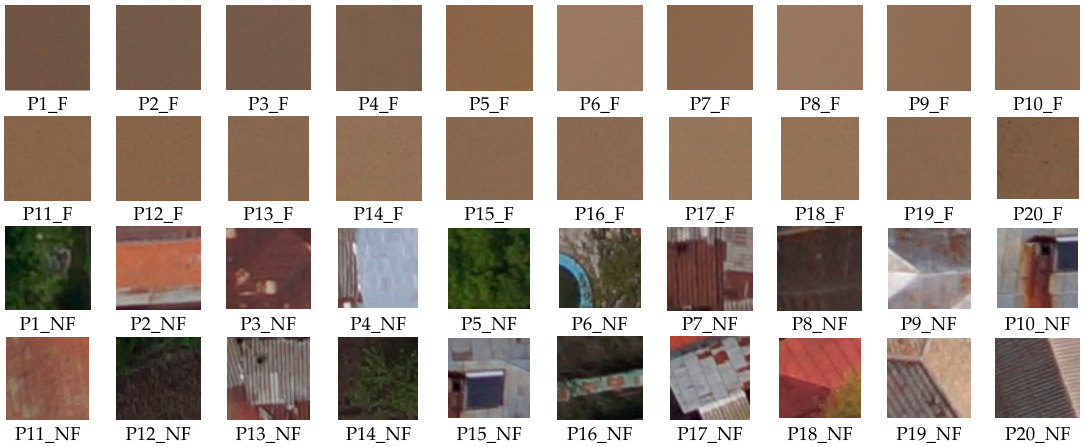
Figure 8. Patches for establish the flood signature (Pi_F as patch with flood and Pj_NF as non flood patch).